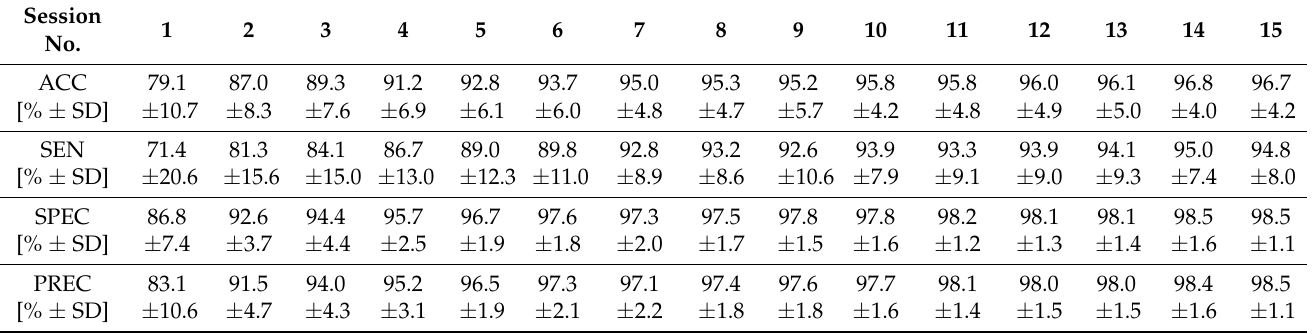
Table 2. Classification measures averaged over all participants obtained for the II approach, in which the PSD estimate coefficients converted to the decibel scale were